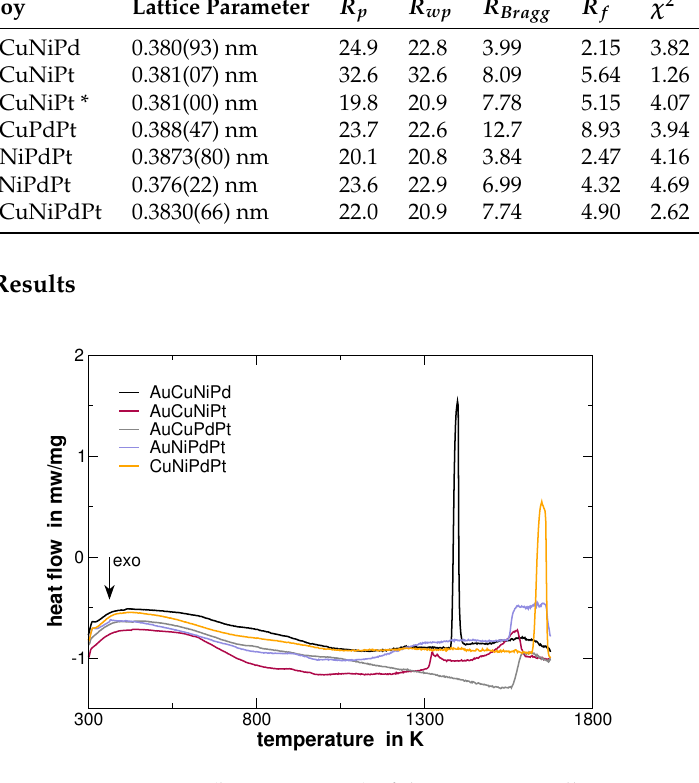
Figure A6. DSC (heating curves) of the quaternary